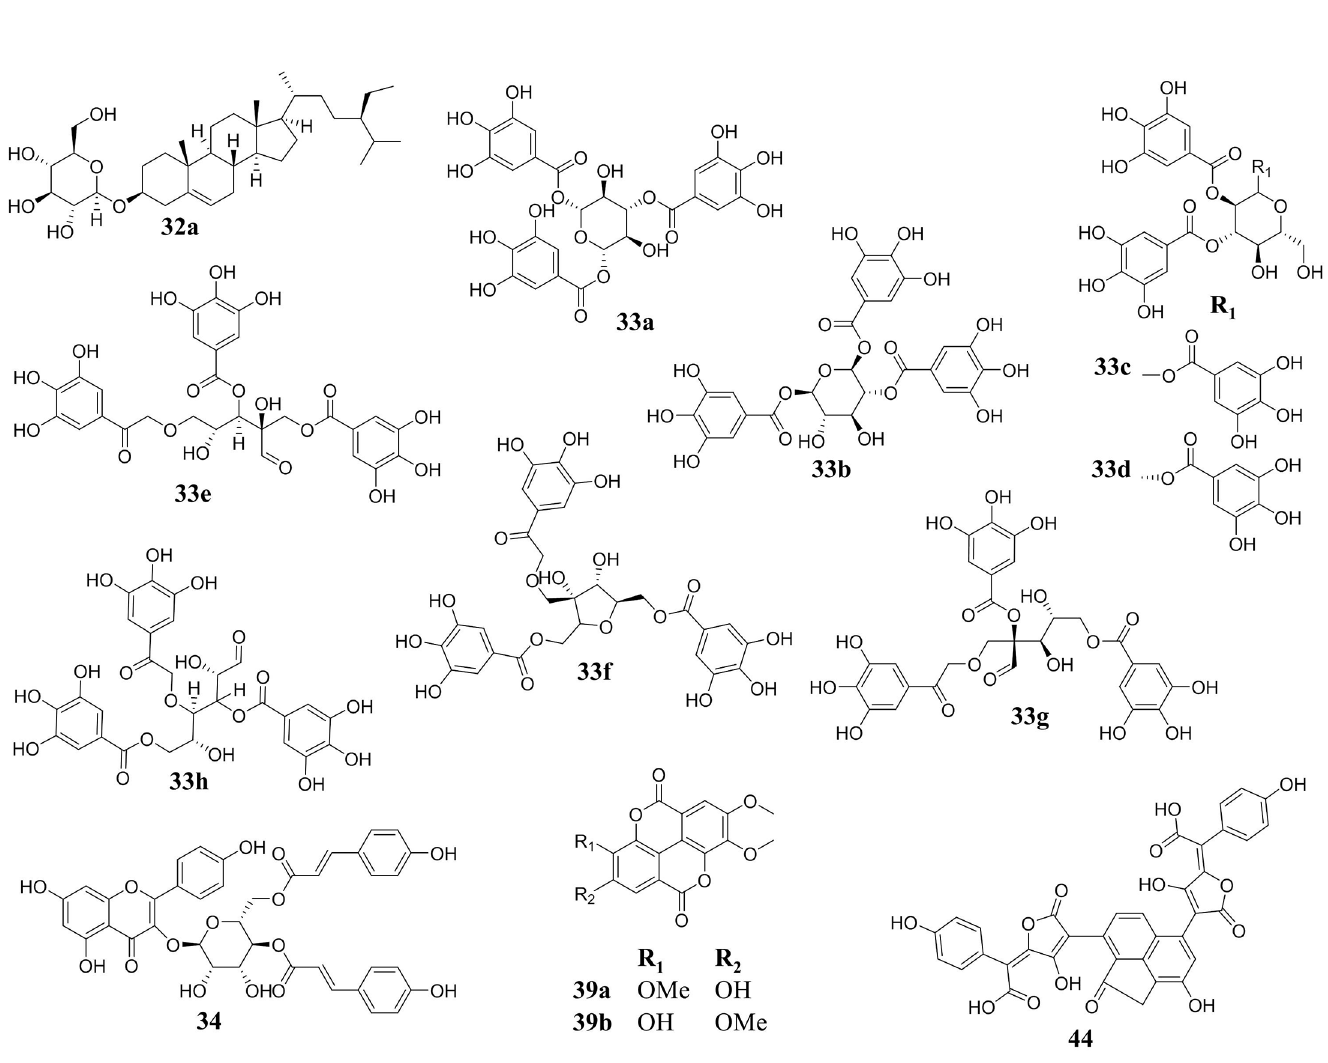
Fig 11. Putative structures of compounds other than pentacyclic triterpenes found in the most active region of 224C-F2 (retention time of 21 – 49 min). Compounds are listed by Peak number, corresponding to Table 5. Peak 32 was determined to be C 35 H 59 O 6 with a relative abundance of 0.30%. Putative structural matches include: ( 32a ) stigmastane and ( 32b ) (3 β , 4 β , 16 α , 21 β , 22 α ) -16, 21, 22, 23, 28- pentamethoxy (9CI) olean- 12- en- 3- ol (Fig 10). Peak 33 was determined to be C 27 H 23 O 18 with a relative abundance of 0.16%. Putative structural matches include: ( 33a ) 1,3,6-tri-O-galloylglucose; ( 33b ) 1,2,6-tri-galloyl- β -D-glucose; ( 33c ) 1,2,3-tri-O-galloylglucose; ( 33d ) 1,2,3-tri-O-galloyl- β -D-glucopyranose; ( 33e ) 2',3,5-tri-O-galloyl-D-hamamelose; ( 33f ) 2- C - [[(3, 4, 5- trihydroxybenzoyl) oxy] methyl]- 1, 5- bis(3, 4, 5- trihydroxybenzoate) D- Ribofuranose; ( 33g ) kurigalin; ( 33h ) 3,4,6-tri-O-galloyl-D-glucose. Peak 34 was determined to be C 39 H 31 O 15 with a relative abundance of 0.65%. Putative structural matches include: ( 34 ) castanoside B. Peak 39 was determined to be C 17 H 11 O 8 or C 20 H 11 O 4 N 2 with a relative abundance of 0.72%. Putative structural matches include: ( 39a ) 3,4,3'-tri-O-methylellagic acid and ( 39b ) 3,3',4'- tri-O-methylellagic acid. Peak 44 was determined to be C 34 H 29 O 15 with a relative abundance of 0.26%. Putative structural matches included ( 44 )